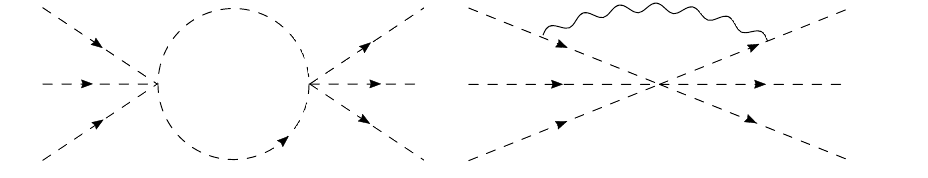
( g 6 ) in (cid:12) (cid:26) . O